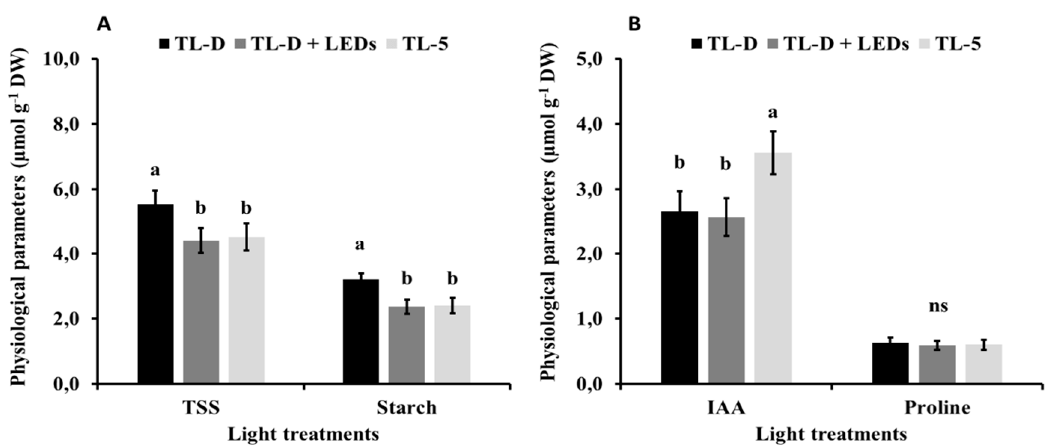
Figure 3. E ff ect of light treatments on total soluble sugars (TSS) and starch (expressed as µ mol glucose equivalents g − 1 DW) ( A ), indole 3-acetic acid (IAA) and proline ( µ mol g − 1 DW) ( B ) in leaves at the end of the experiment (8 weeks). Each parameter was analyzed individually. Values are the means ± standard deviations (error bars) of five plants per treatment. Bars with di ff erent letters are significantly di ff erent at p < 0.05 (ANOVA and LSD test). ns: not significant.